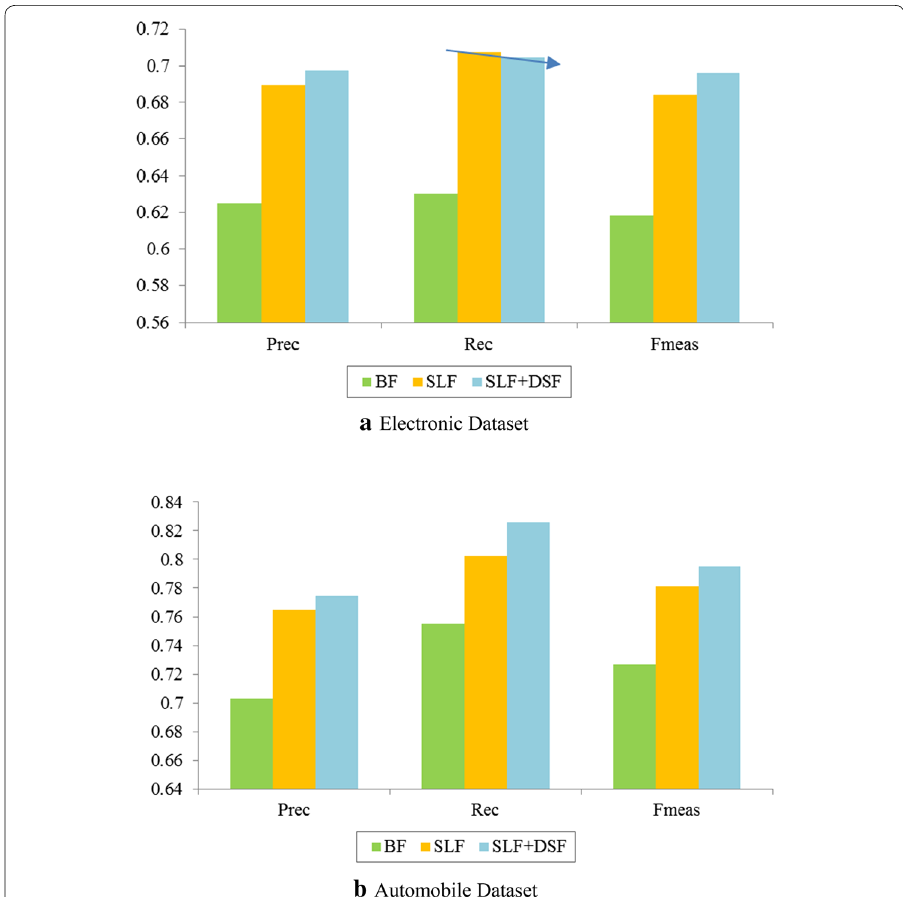
Fig. 5 Average performance of our proposed features compared with baseline features